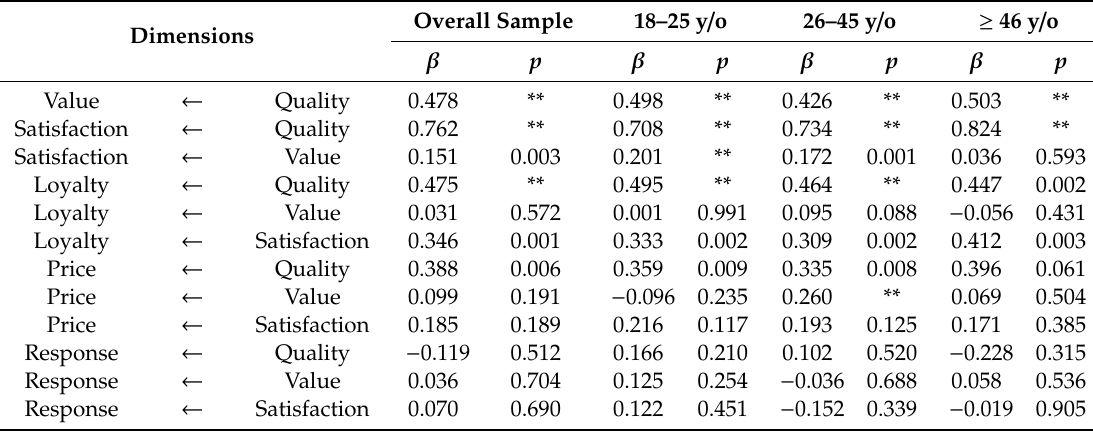
Table 4. Standardised regression coe ffi cients and p -values.